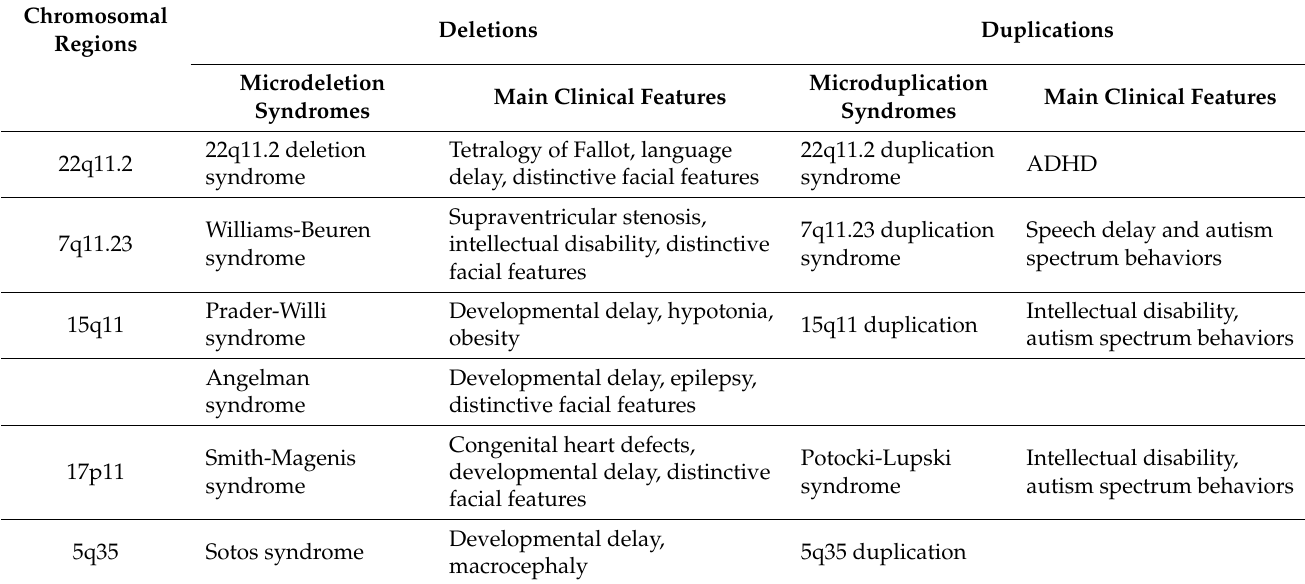
Table 1. Classical microdeletion syndromes and reciprocal